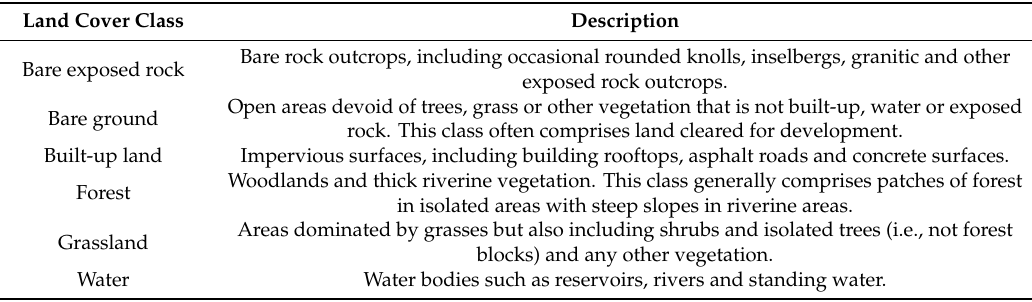
Table 2. Land cover classification